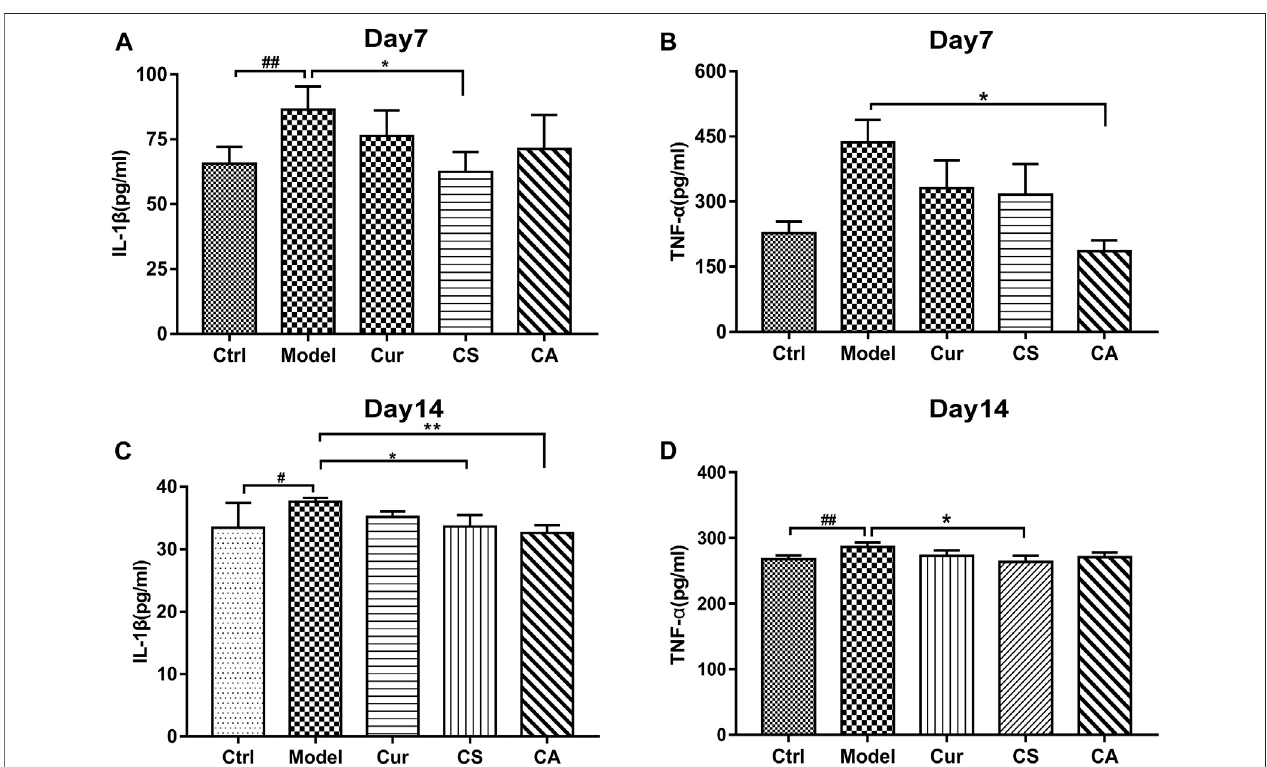
FIGURE4| SerumIL-1 β andTNF- α ofMIA-inducedKOAratsineachgroupatdays7and14. (A) SerumIL-1 β atday7afterKOAinduction. (B) SerumTNF- α atday 7afterKOAinduction. (C) SerumIL-1 β atday14afterKOAinduction. (D) SerumTNF- α atday14afterKOAinduction.Dataarepresentedasthemean±SD( n =5). # p < 0.05, ## p < 0.01 vs. Ctrl group; * p < 0.05 vs. model